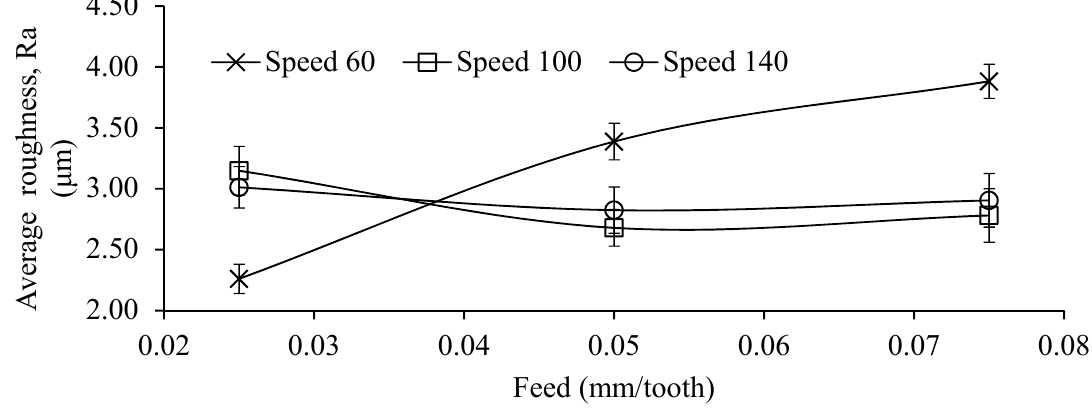
Figure 1. Effect of feed and speed during milling of nanoparticle reinforced MMCs.